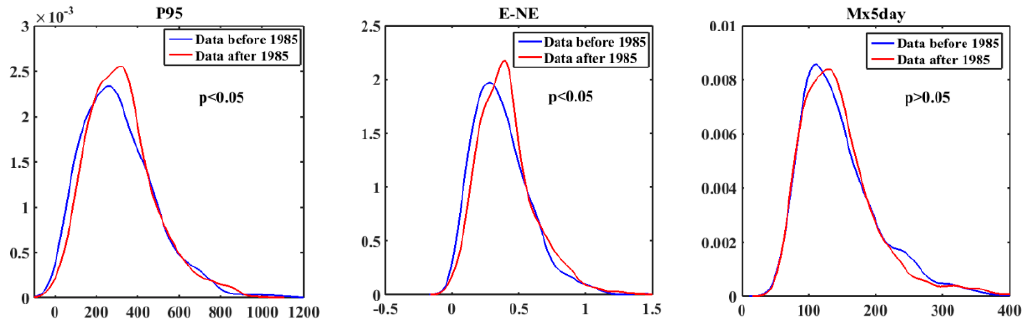
Figure 8. Density distributions for P95 , E-NE and Mx5 , respectively, for the pre-1985 (blue) and post-1985 (red) periods. Statistical significance was estimated using the Kolmogorov–Smirnov test for distributions of the extreme precipitation indices.